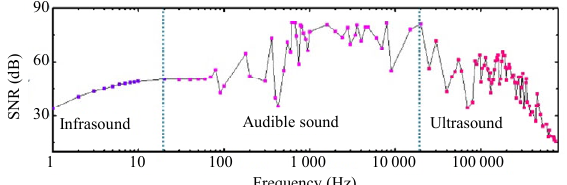
Fig. 4 Broadband frequency response of the DCF-based acoustic vibration sensor.